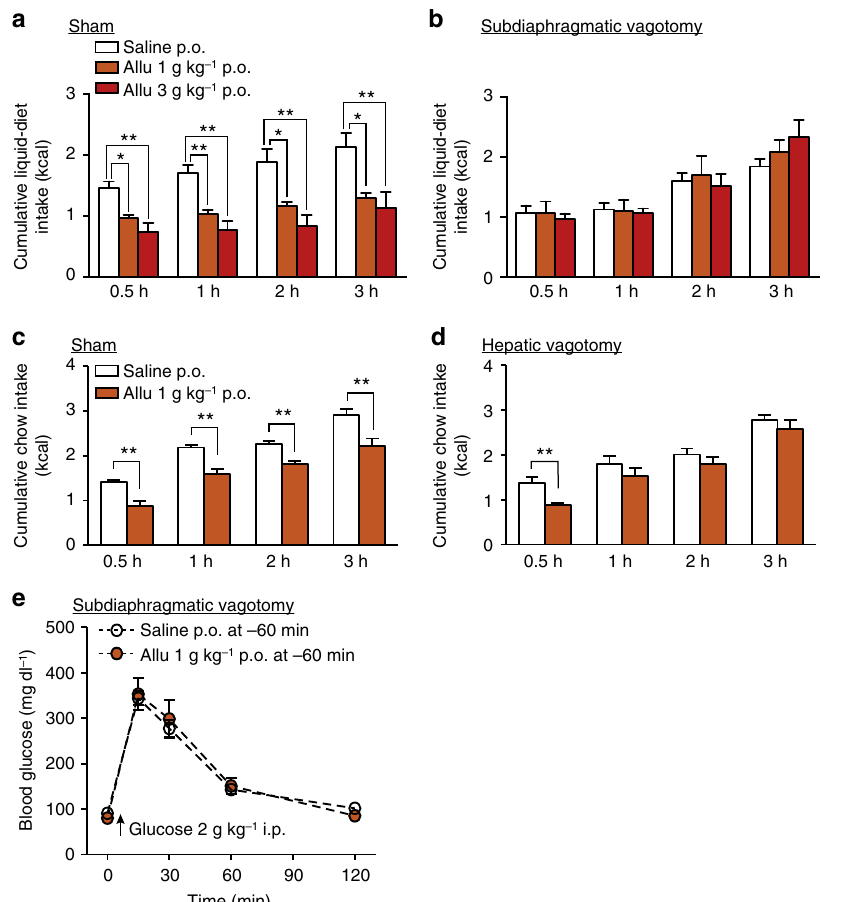
Fig. 9 Subdiaphragmatic and hepatic vagotomy counteract metabolic actions of D -allulose. a , b Allu (1 and 3 g kg − 1 , p.o.) reduced food intake in sham- operated ( a , n = 6 – 7) but not subdiaphragmatic vagotomized C57BL/6J mice ( b , n = 6 – 12) fasted overnight (16 h). * p < 0.05 and ** p < 0.01 by one-way ANOVA followed by Tukey ’ s test. c , d Anorexigenic effect of Allu (1 g kg − 1 , p.o.) in sham-operated mice fasted overnight ( c , n = 10 – 11) was blunted in hepatic vagotomized mice ( d , n = 6) for 1 – 3 h, but not 0.5 h, after injection. * p < 0.05 and ** p < 0.01 by unpaired t -test. e Allu (1 g kg − 1 , p.o.) failed to improve glucose tolerance in subdiaphragmatic vagotomized mice fasted for 4 h ( n = 6). Error bars are